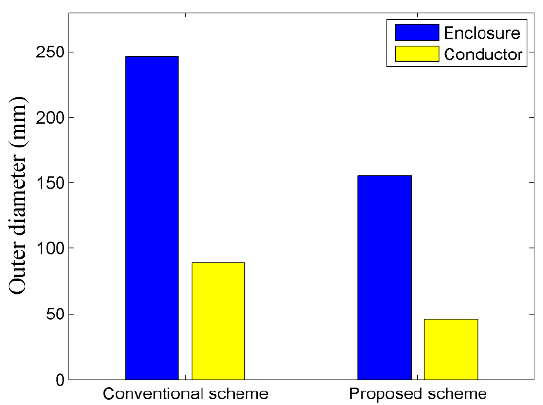
Figure 15. Dimensional comparison of FGIL comprising of proposed thermoplastic enclosure and stranded conductor with the conventional GIL scheme.